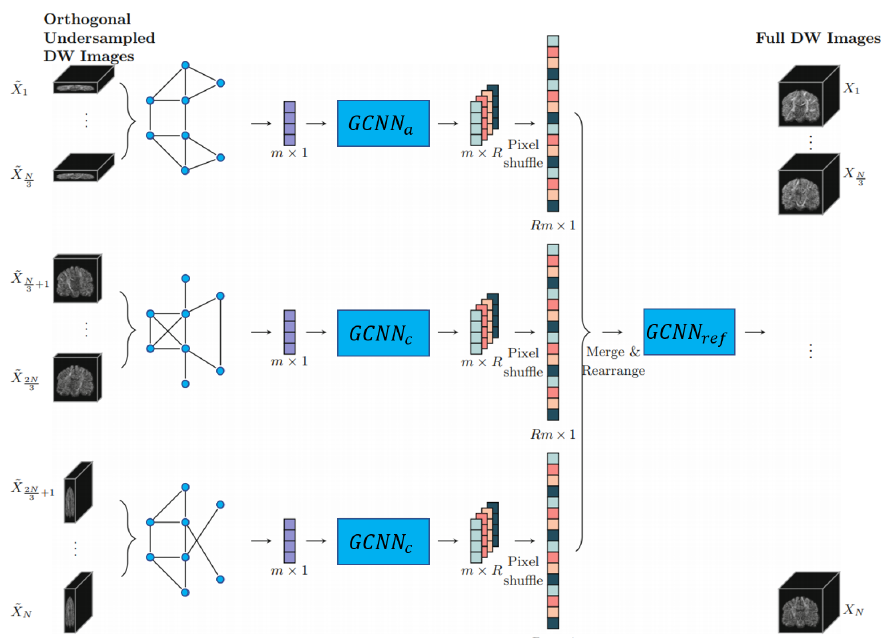
Figure 9. Individual GCNs model the axial, coronal and sagitall scan direction. A refinement GCN is used to generate the proposed super-resolution reconstruction. Image adapted from